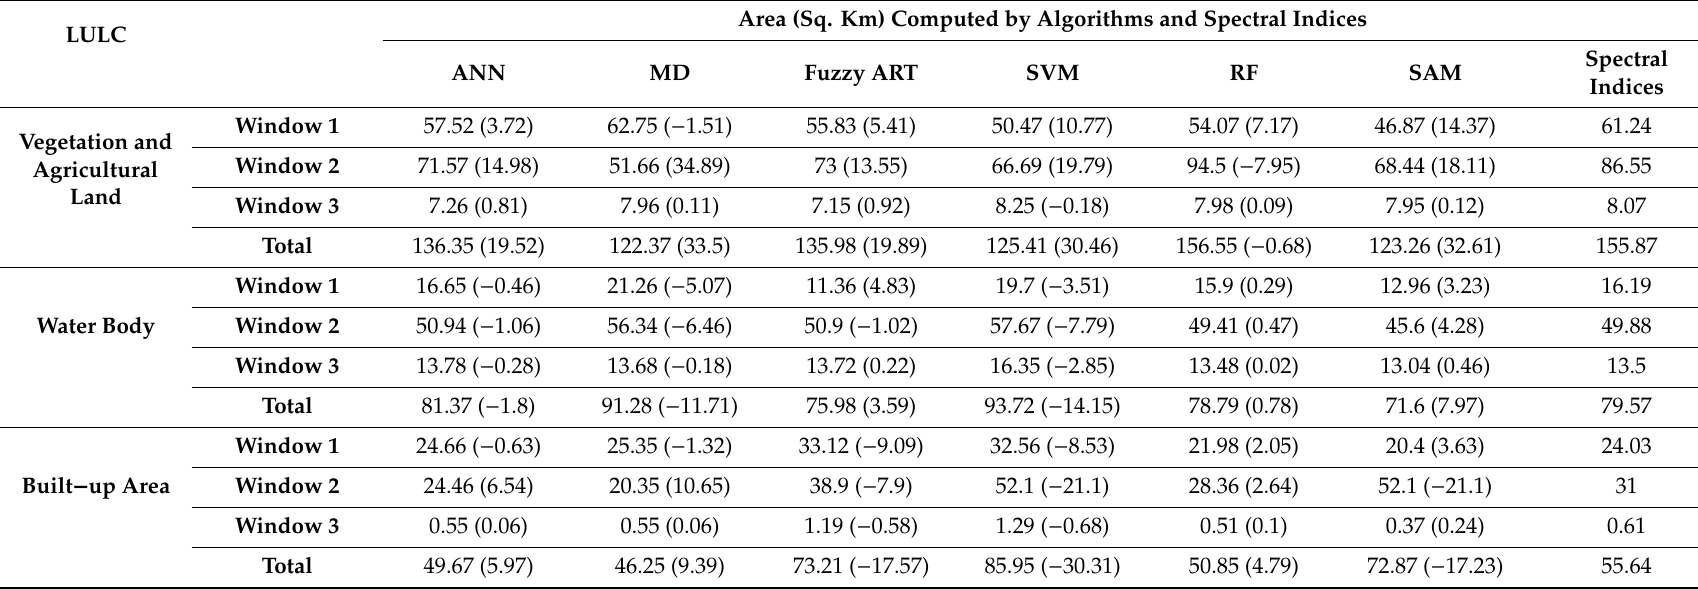
Values within parenthesis indicate the departure of area computed in spectral indices and respective